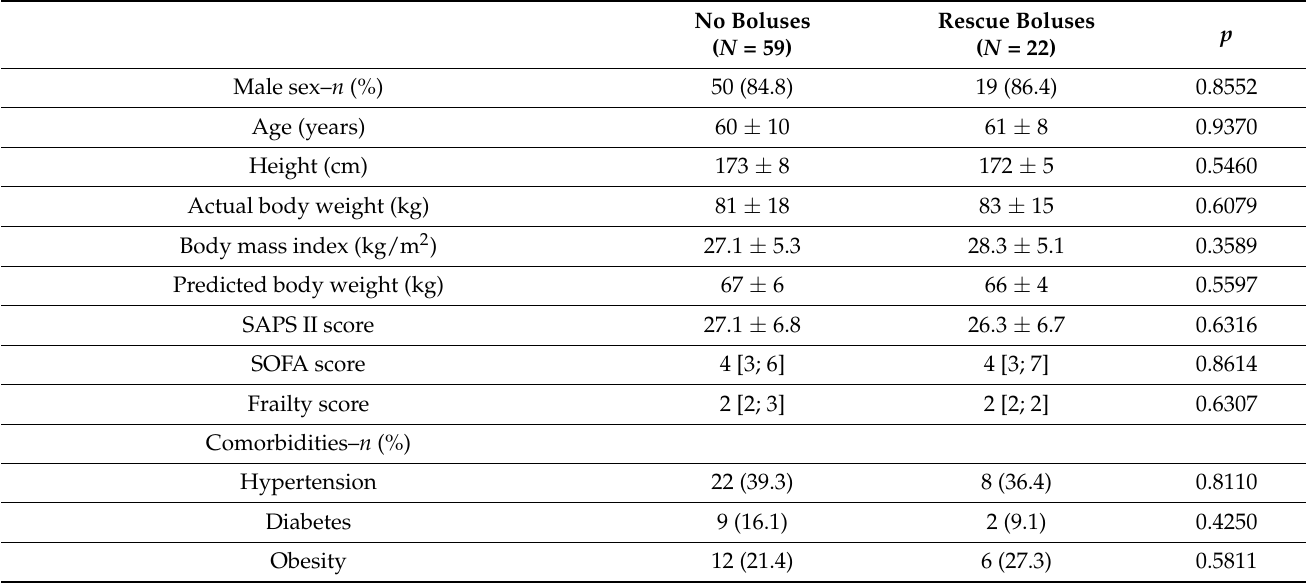
Table 3. Comparison of baseline characteristics and worst clinical data over the first 10 days of stay in patients who did vs. those who did not receive a short, rescue course of high-dose boluses of